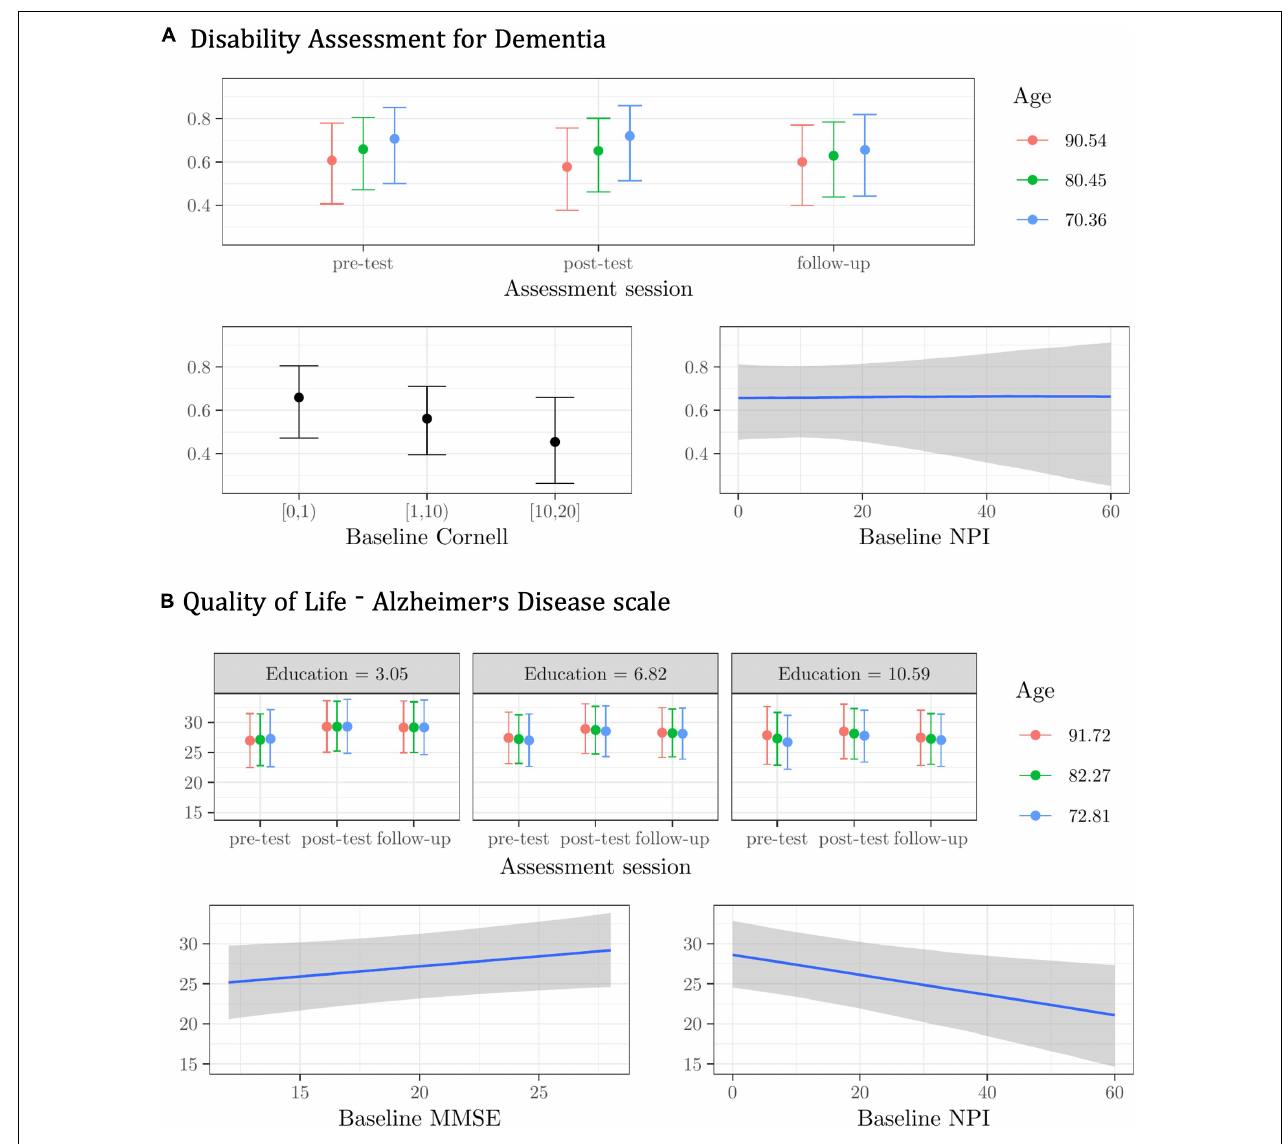
FIGURE 3 | Plots of the best model’s predictions for the secondary outcome measures. (A) Disability Assessment for Dementia (DAD). (B) Quality of Life-Alzheimer’s Disease scale (QoL-AD). For each measure, the plots represent the conditional effects of the predictors on the dependent